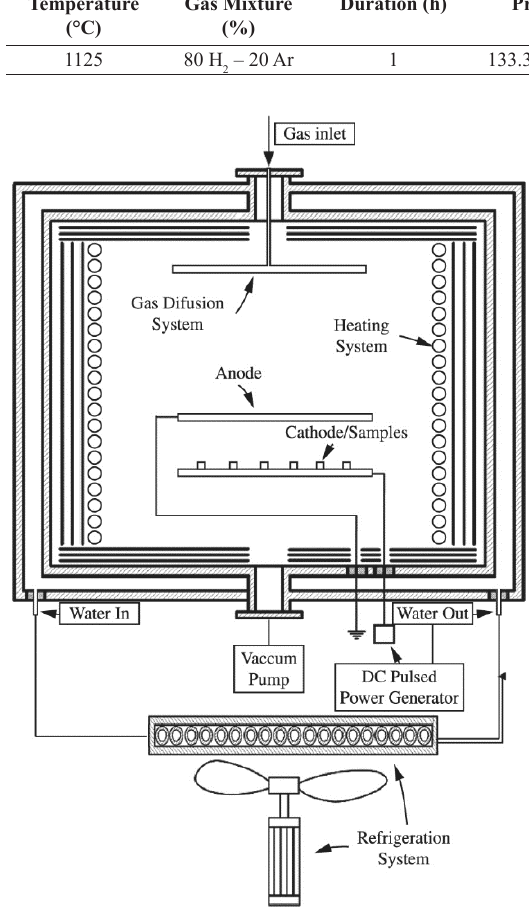
Figure 1. Schematic representation of the plasma carburizing